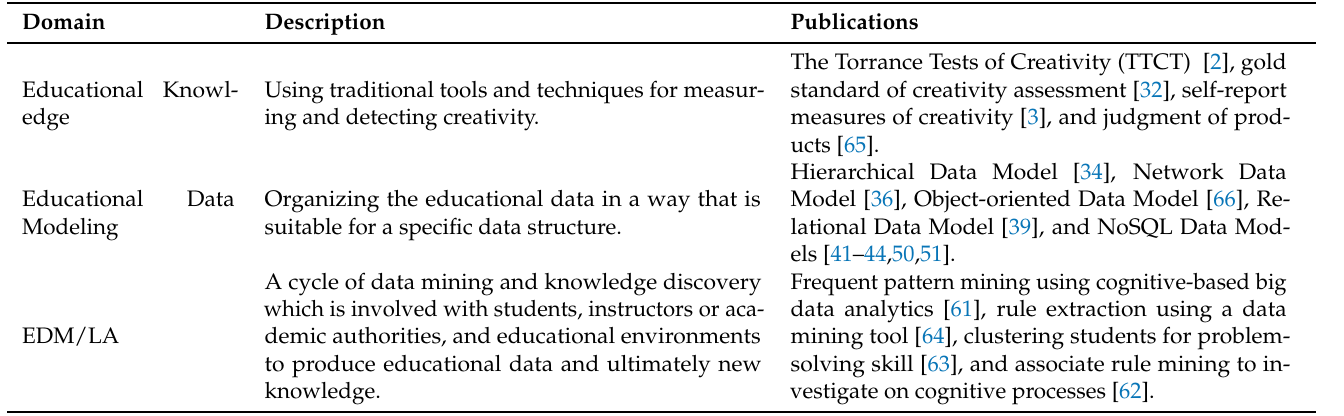
Table 1. The publications of the three research areas in the literature: Educational Knowledge, Educational Data Modeling, and